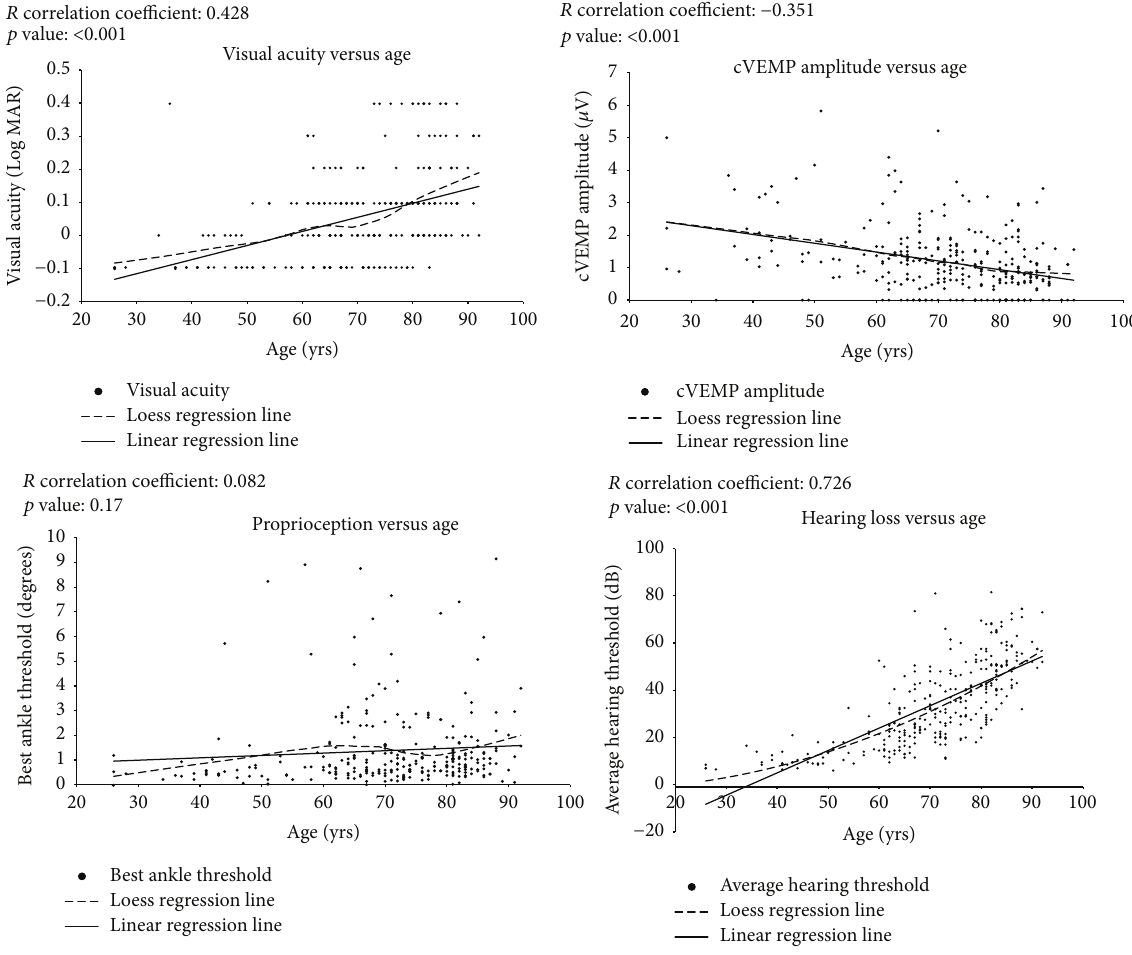
Figure 1: Individual associations between sensory system and